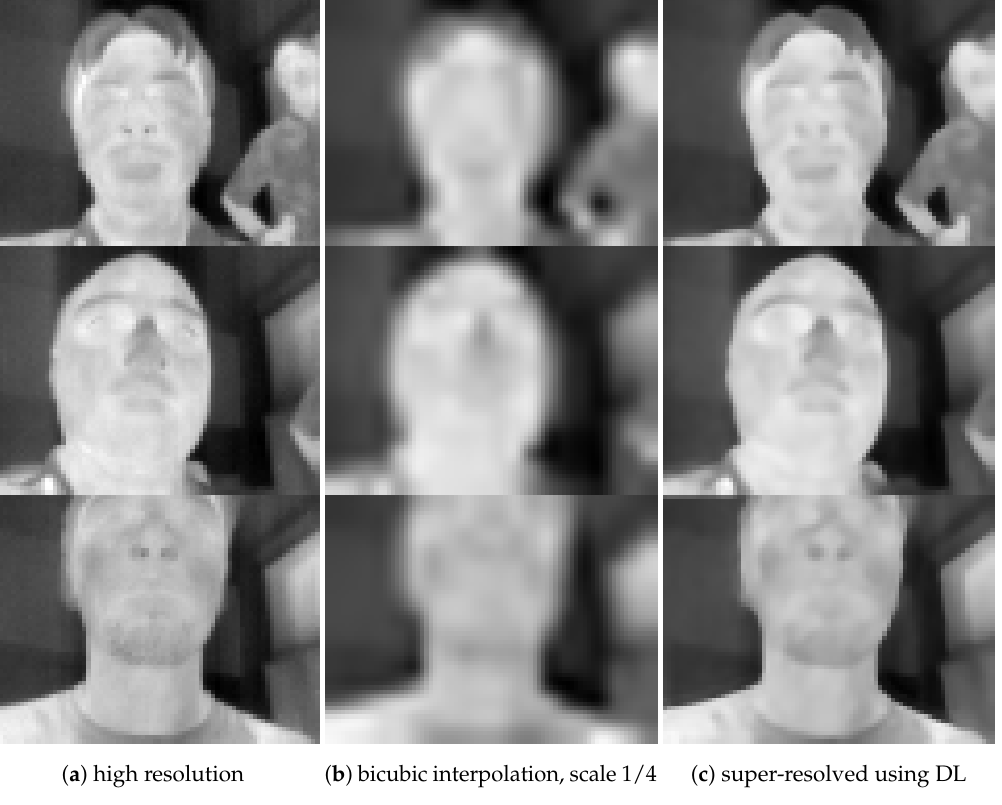
Figure 2. Examples of corresponding images from the Lepton 8-bit